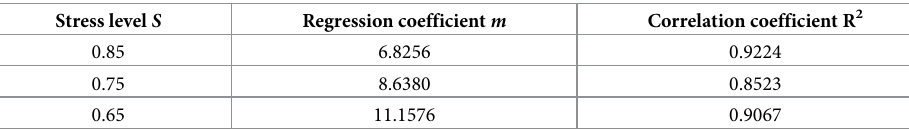
Table 11. Regression parameter